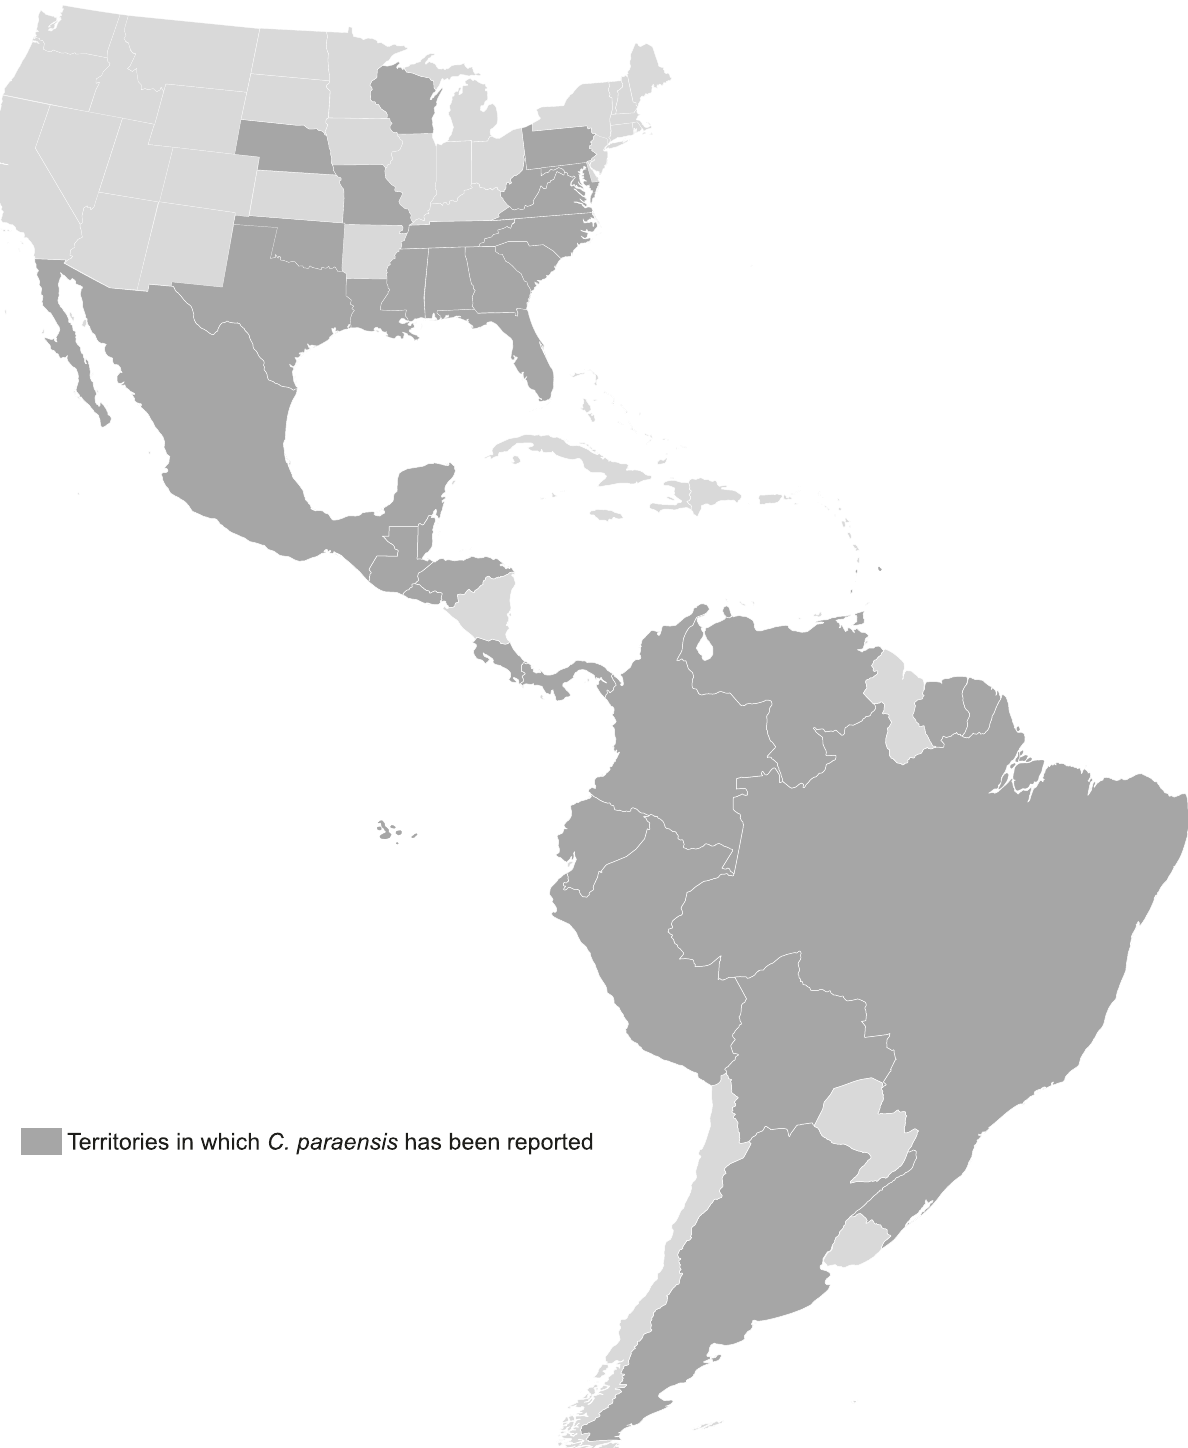
Fig. 2 Distribution of Culicoides paraensis in the Americas. Dark gray indicates countries and states where C. paraensis has been reported 61,96 – 101 . Map template modi fi ed from ref. 102 a three-month period. Over one million mosquitoes were captured, and a signi fi cant number of new viruses were isolated.